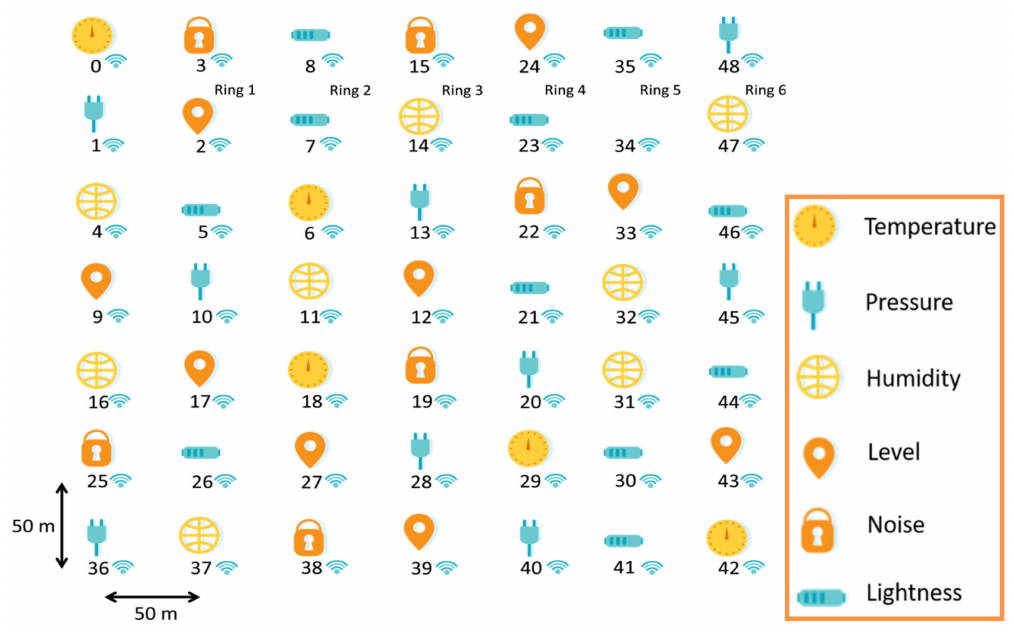
Figure 2. Network topology with the coordinating node in the lower-left corner and the sensor nodes located in the WSN with di ff erent symbols as a function of the detected parameter; in the box at the bottom right, a clear indication of the meaning of some